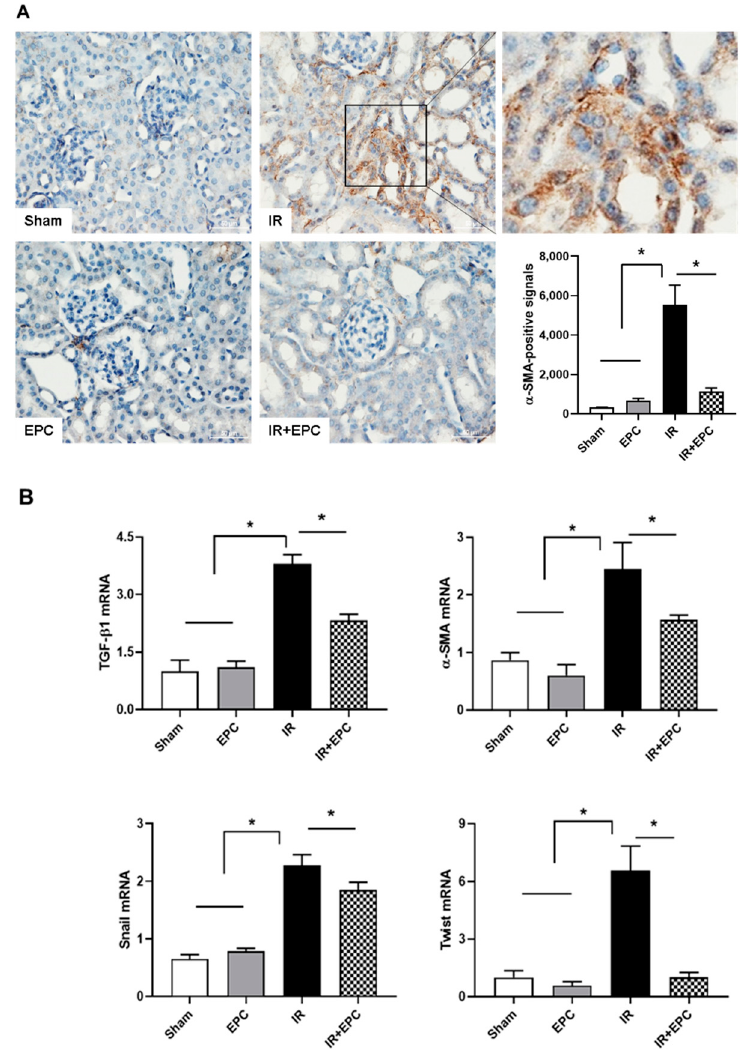
Figure 7. Effects of EPCs on IRI-induced renal fibrosis. α -SMA immunohistochemical staining was performed to verify fibrosis ( A ). mRNA expression levels of TGF- β 1, α -SMA, Twist, and Snail were analyzed by quantitative real-time PCR ( B ). Scale bar, 50 μ m. Data are means ± SEMs. * p < 0.05.